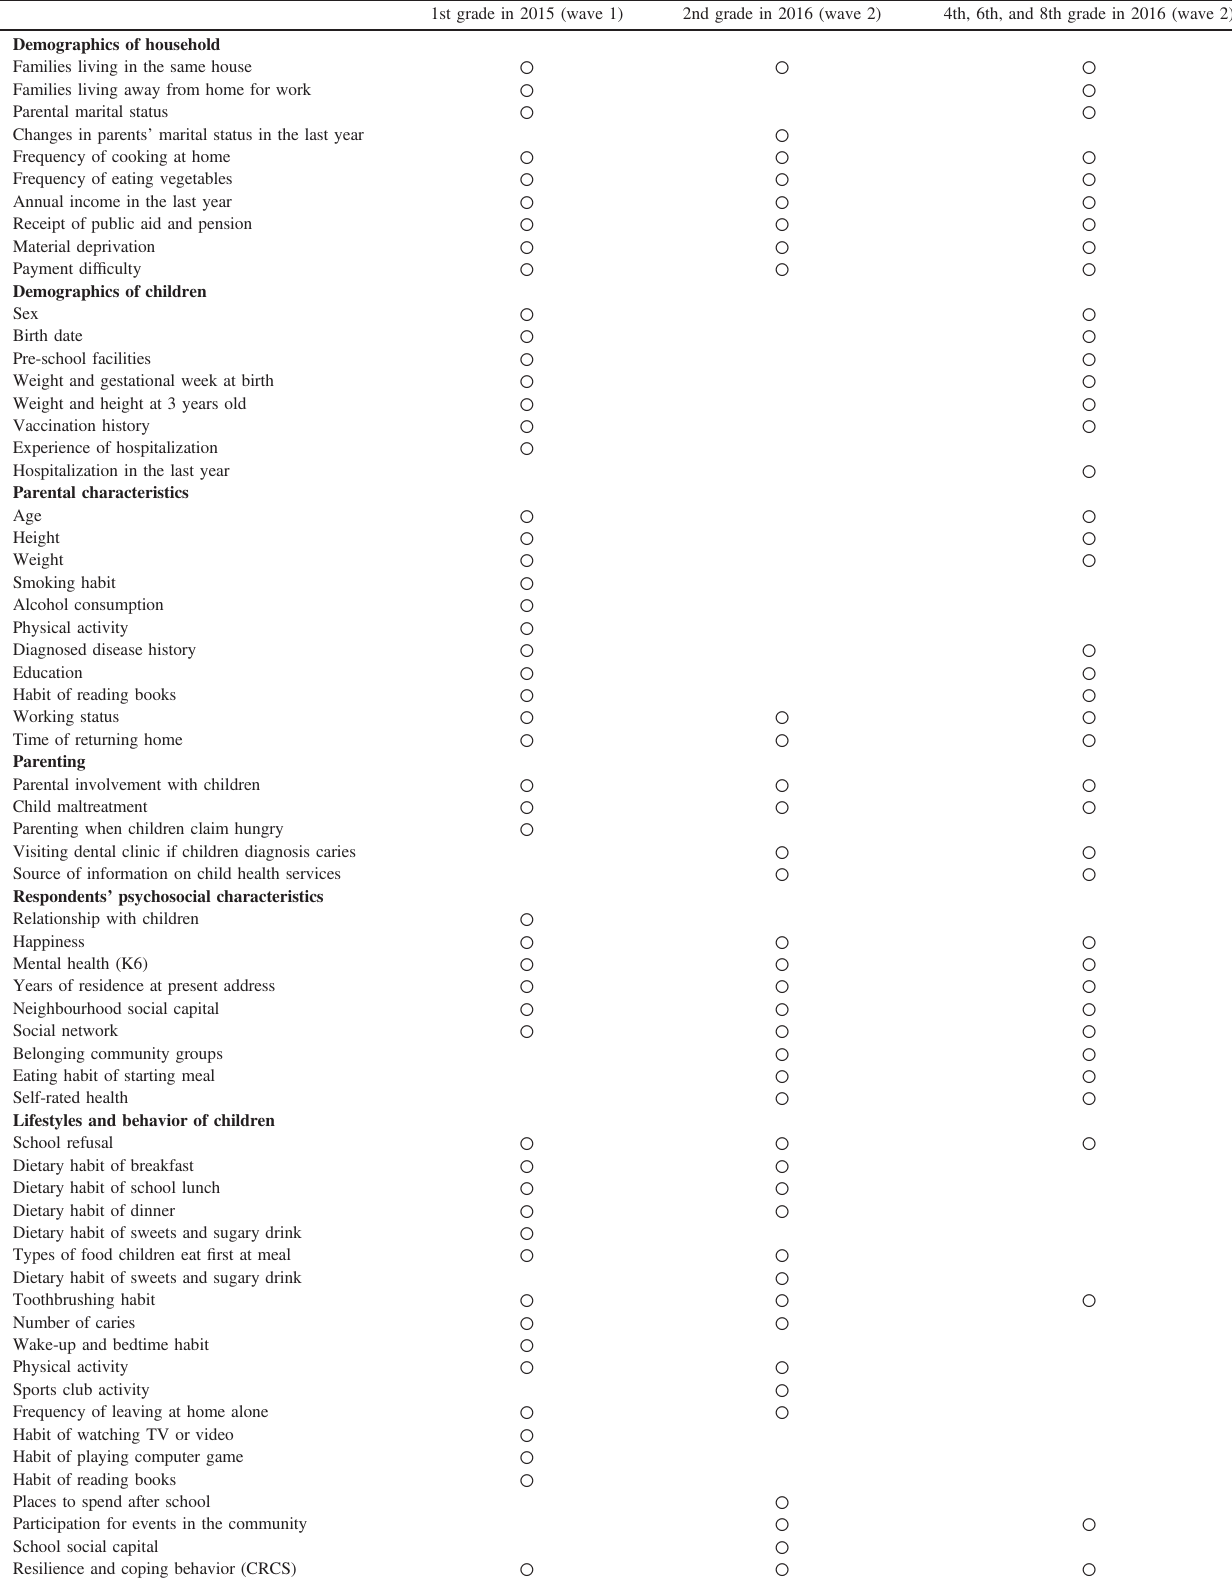
Table 1. List of measures answered by caregivers in A-CHILD study in 2015 and